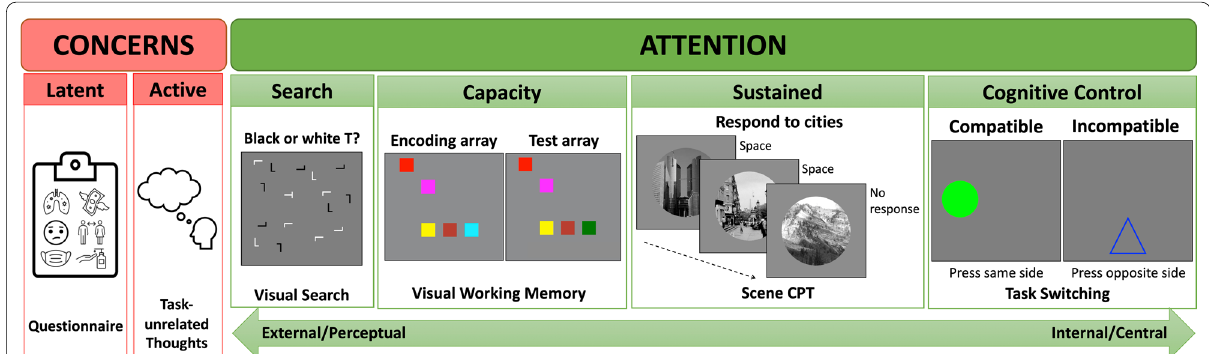
Fig. 1 A schematic of the tasks. Left. A pre-task questionnaire asked participants to rate their level of concerns about COVID-19. Participants also estimated the rate of task-unrelated thoughts (TUTs) at the completion of each cognitive task. Right. The four attention tasks included visual search, visual working memory, scene CPT (sustained attention), and task switching. Participants were tested in one of four orders of the tasks based on a balanced Latin Square